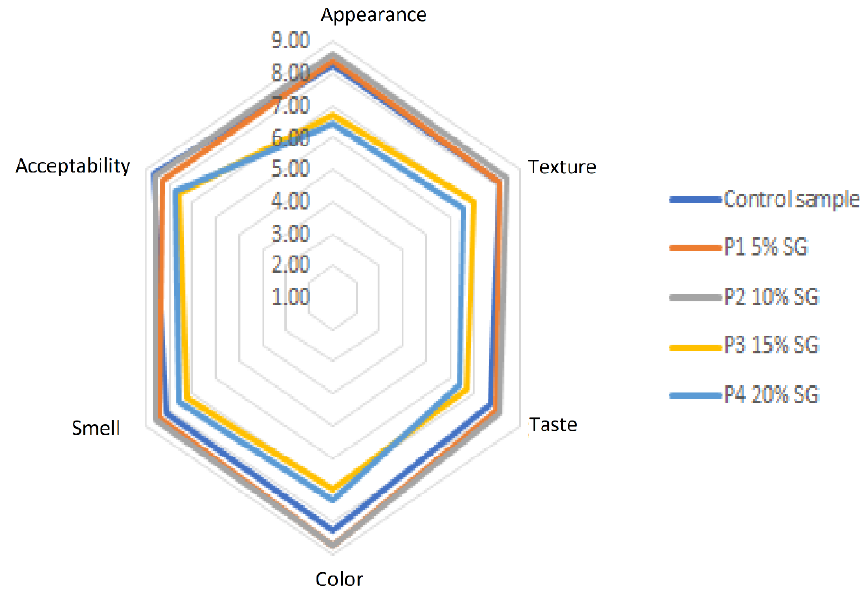
Figure 4. Sensory scores for spent grain pasta.